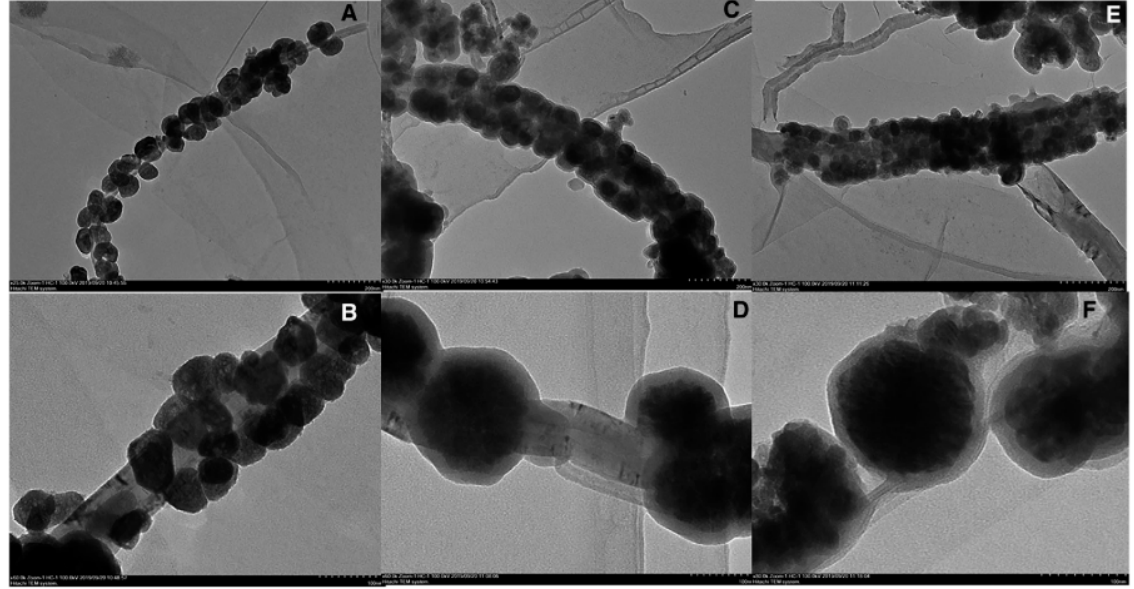
Figure 13. ( A , B ) TEM images of the prepared MCNTs, ( C , D ) TEOS@MCNTs, and ( E , F ) cAMP- MIPs@MCNTs. Reprinted with permission from Ref. [112]. Copyright (2021) Weinheim.